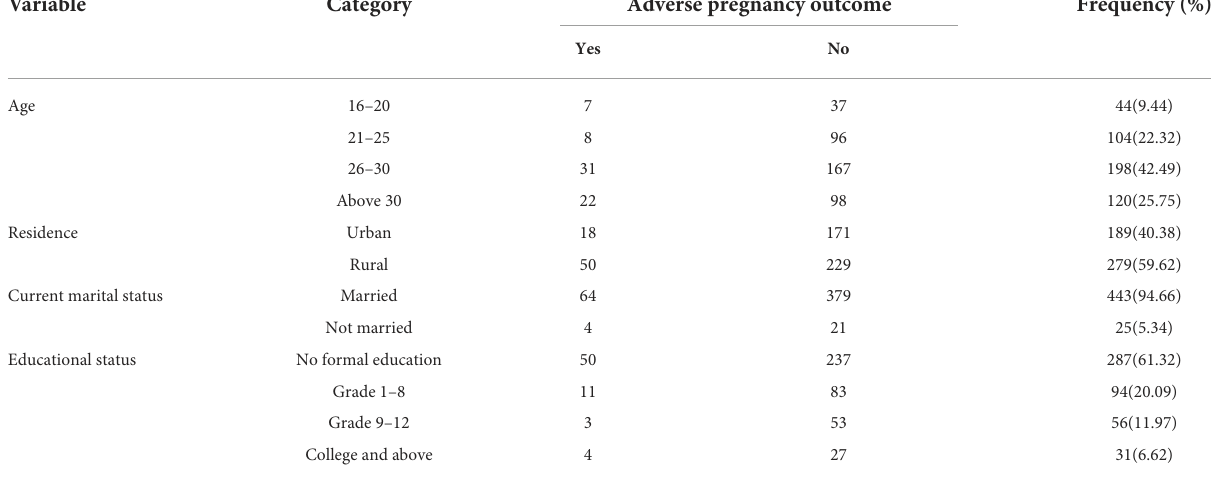
TABLE 1 Socio-demographic characteristics of study participants in Northwest, Ethiopia, 2021 ( n = 468).